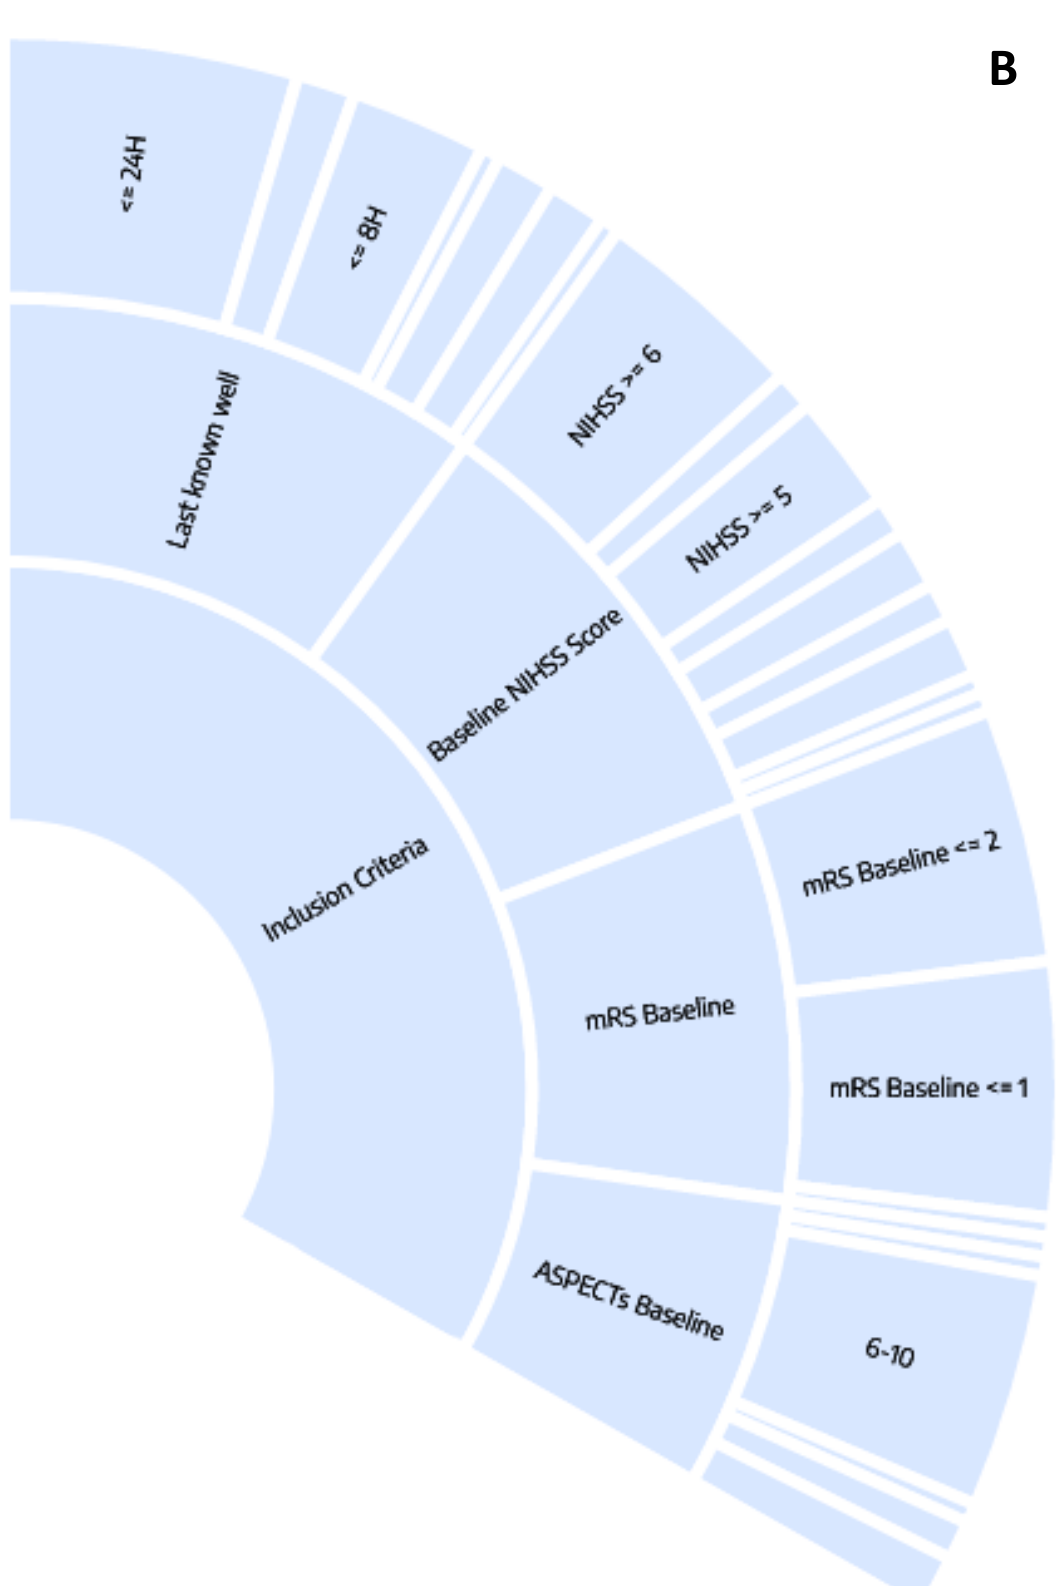
Figure 1. ( A ) Distribution of inclusion criteria among different studies. ( B ). Heterogeneity in different cut-offs used within inclusion criteria.